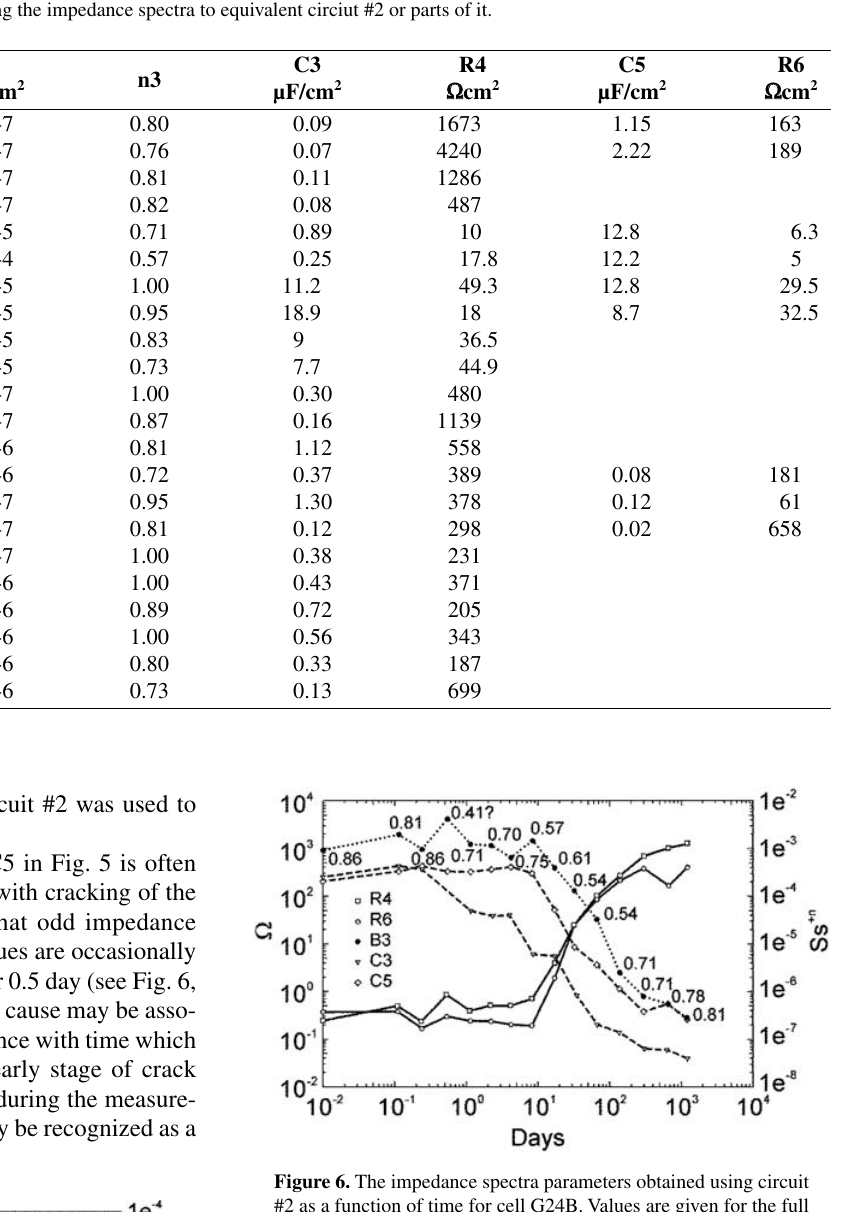
Table 4. Examples of data derived from fitting the impedance spectra to equivalent circiut #2 or parts of it.